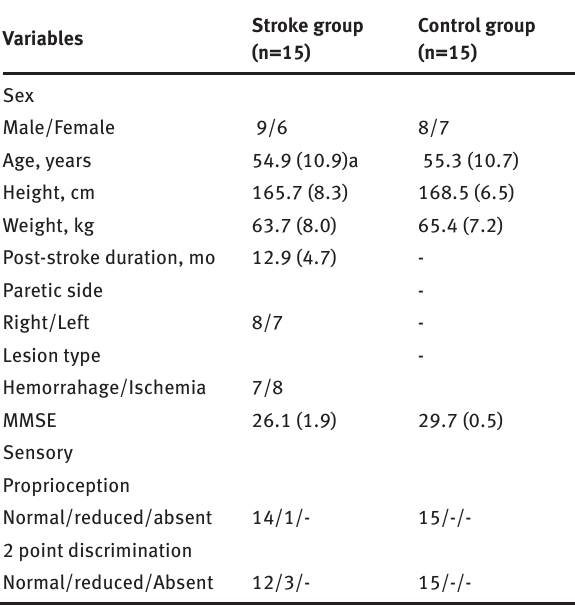
Table 1: Common and clinical characteristics of the subjects (N=30) MMSE, mini-mental state examination.